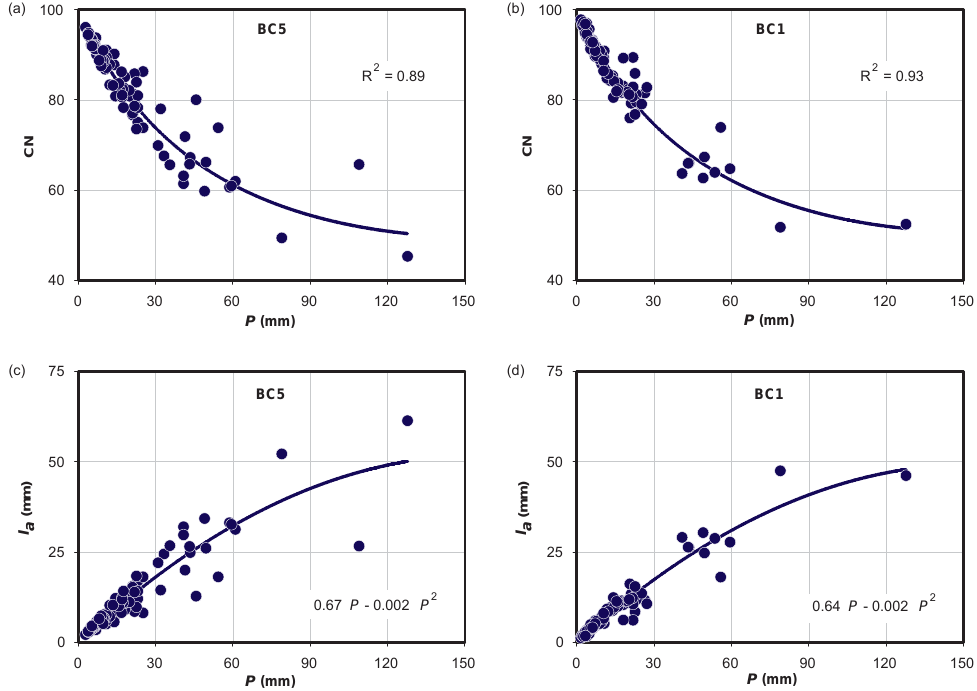
Figure 2. Variation of CN ( λ = 0.2) with P in watersheds (a) BC5 and (b) BC1, near Greenville, SC. Variation of I a with P in (c) BC5 and (d) BC1 (see Santikari, 2017, or Santikari and Murdoch, 2018, for study area description). Best-fit curves for I a are quadratic functions of P with zero intercept. Corresponding best-fit curves for CN were derived from those of I a using Eqs. (3) and